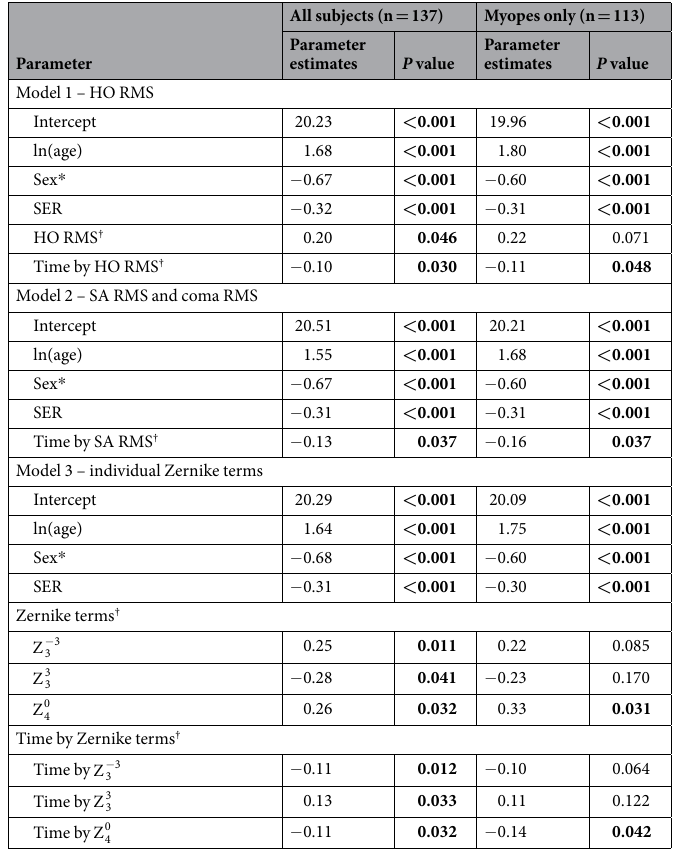
Table 2. Statistically significant fixed effects and parameter estimates of the influences on change in axial length. Other parameters and interactions with time did not show statistically significant effects (all P > 0.05) in the LMMs. SER: spherical equivalent refraction; HO RMS: RMS of total higher-order aberrations (3rd to 6th orders inclusive); SA RMS: RMS of spherical-like aberrations ( Z 40 and Z 60 combined); coma RMS: RMS of